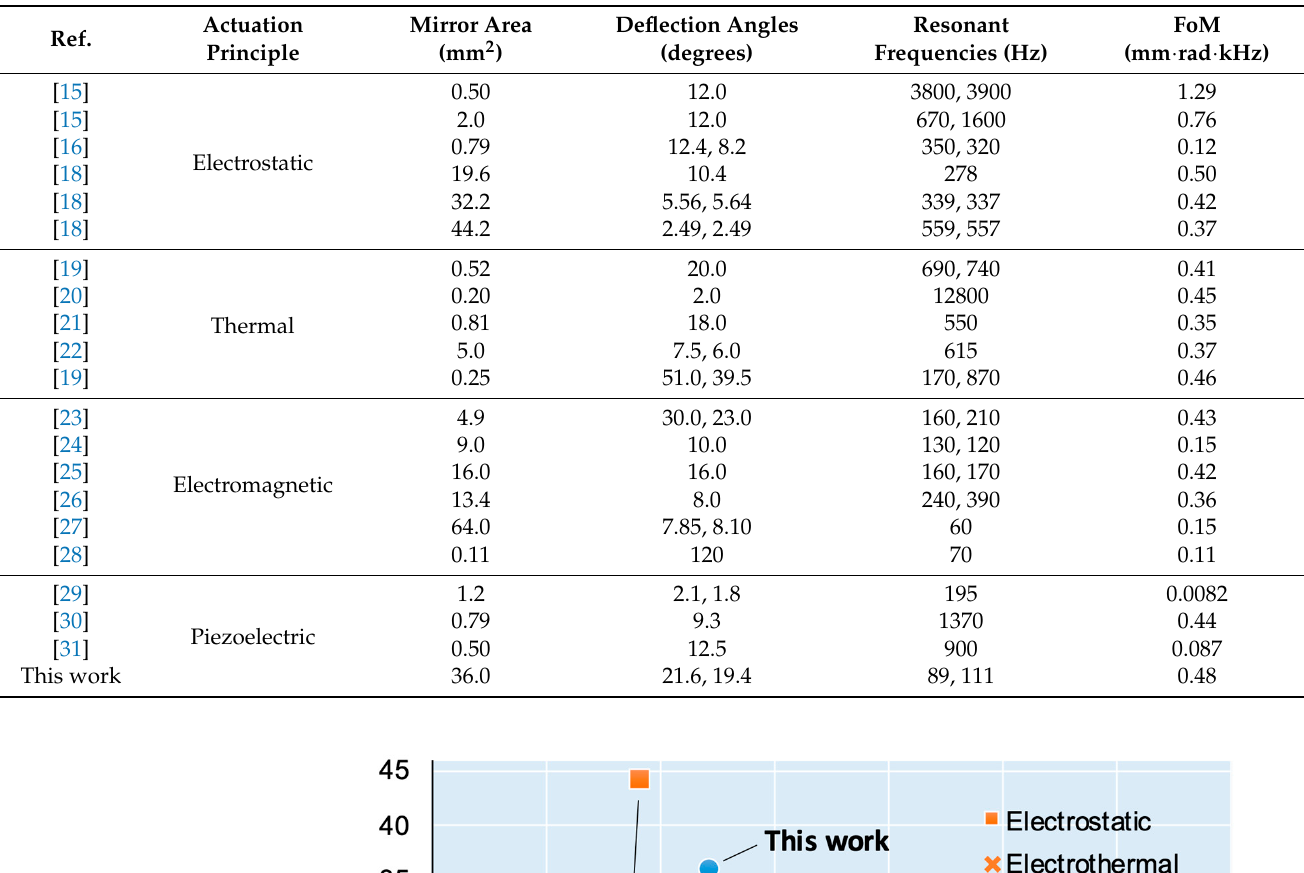
Table 2. Characteristics of 2-DoF quasi-static scanners.